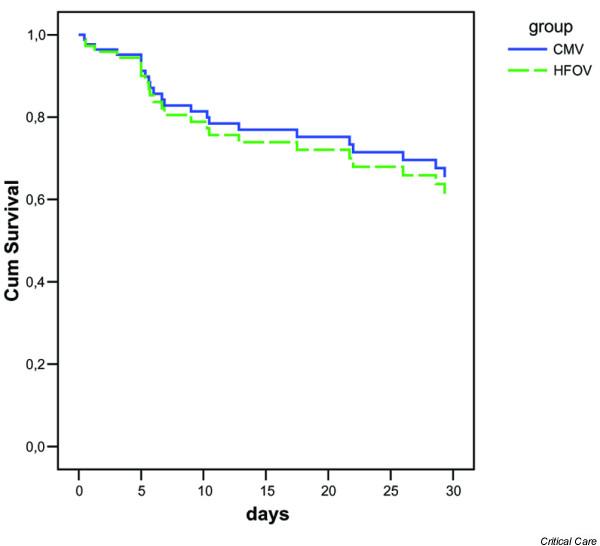
Cumulative mortality incidence for high frequency oscillatory ventilation (HFOV) versus conventional mechanical ventilation (CV). Curves are estimates of cumulative risk corrected for study site, baseline oxygenation index and ventilatory index, APACHE II score, age and weight.